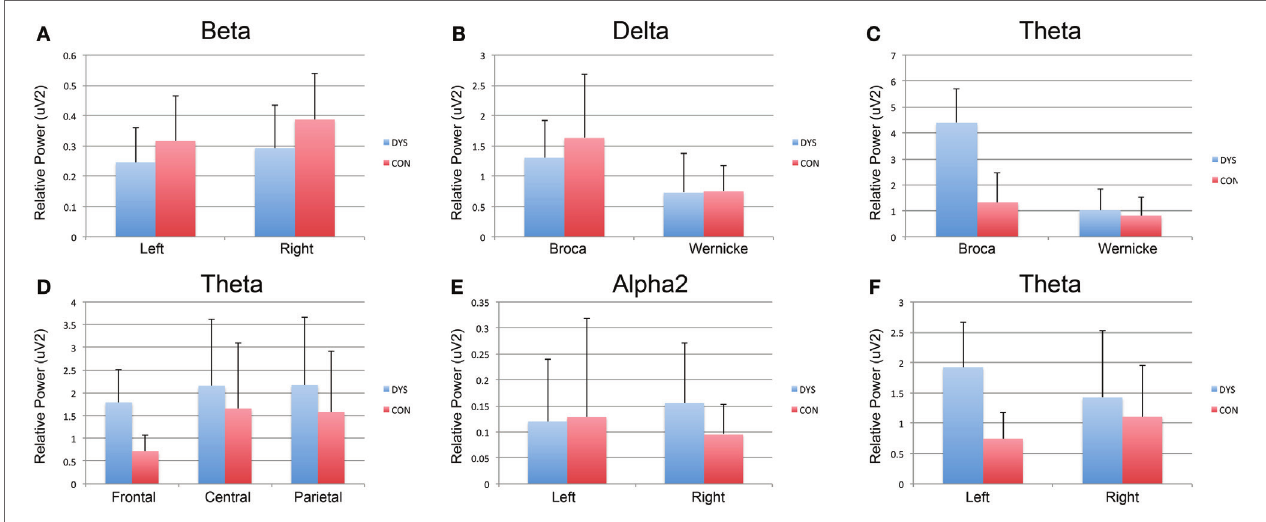
FigUre 1 | Within-group analysis of eeg band for region, language, and hemisphere . Dyslexia subjects are depicted in blue and controls in red. (a) Significantly decreased EEG power in the left compared to the right hemisphere for Beta in children with dyslexia. (B,c) Significantly greater Delta and Theta EEG power, respectively, at Broca’s when compared to Wernicke’s area. (D) Significantly, decreased frontal theta EEG power when compared to central and parietal regions for control subjects. (e) Significantly decreased EEG power in the left compared to the right hemisphere for Alpha2 EEG power in children with dyslexia. (F) Significantly decreased EEG power in the left compared to right hemisphere for the Theta EEG power in